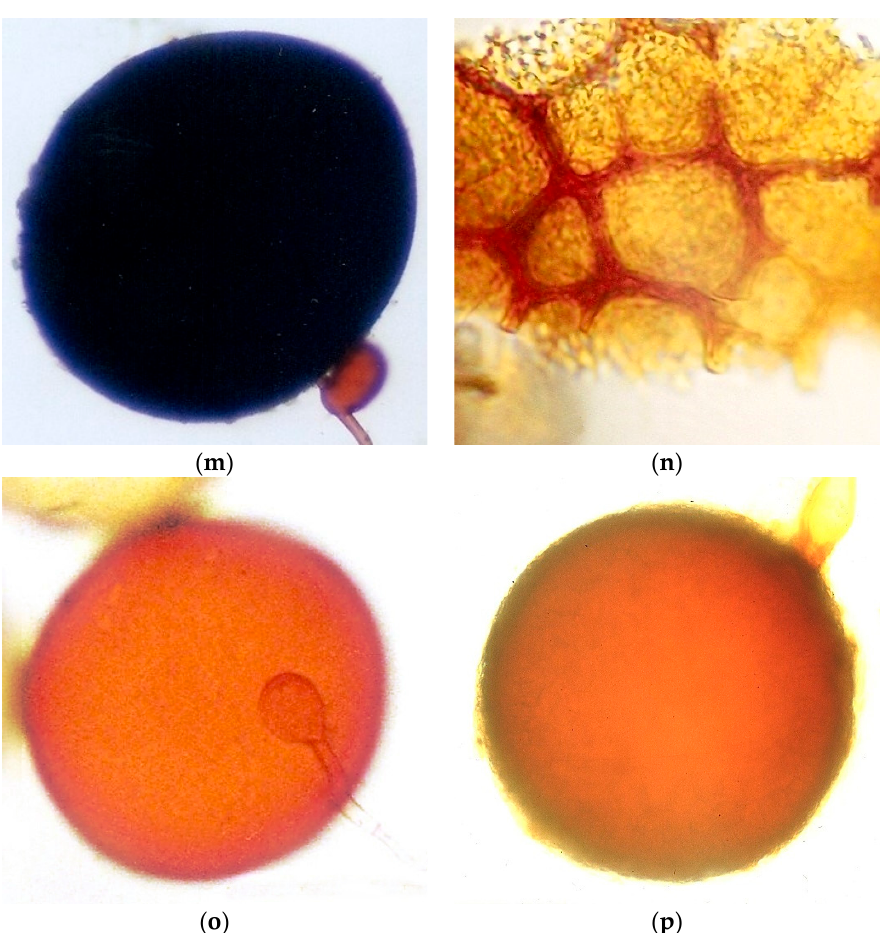
Figure 5. Colonized roots with entry points and vesicles ( a ); detail of entry points and hyphal colonization ( b ); vesicles and arbuscules ( c ); AMF spores of Acaulospora foveata ( d ); A. scrobiculata ( e , f ); A. spinose , general aspect of spores ( g ); Melzer reaction of inner spore wall ( h ); wall ornamentation detail ( i ); Gigaspora sp. ( j ); Racocetra gregaria , general aspect of spores ( k ); spore wall ornamentation detail ( l ); Scutellospora reticulata , general aspect of spore ( m ); spore wall ornamentation detail ( n ); Scutellospora aurigloba ( o ); and Septoglomus constrictum ( p ) found in this study.